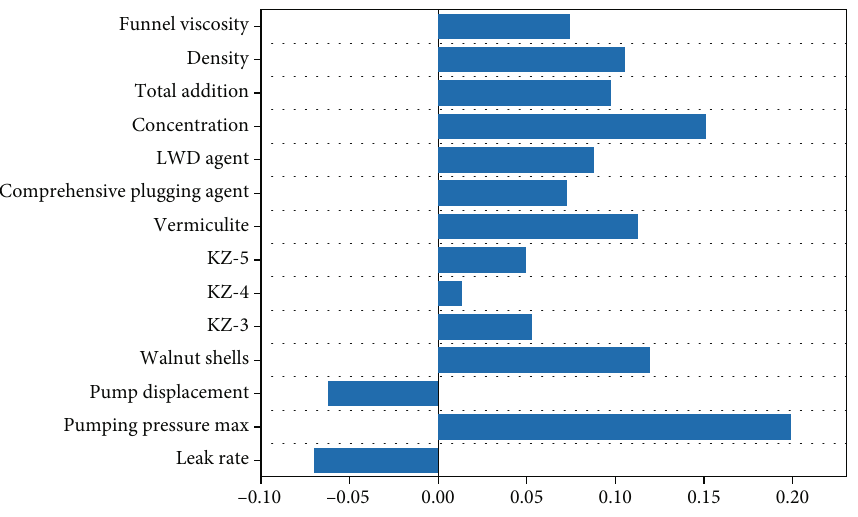
Figure 16: Correlation analysis between each characteristic data and the e ff ect of missing